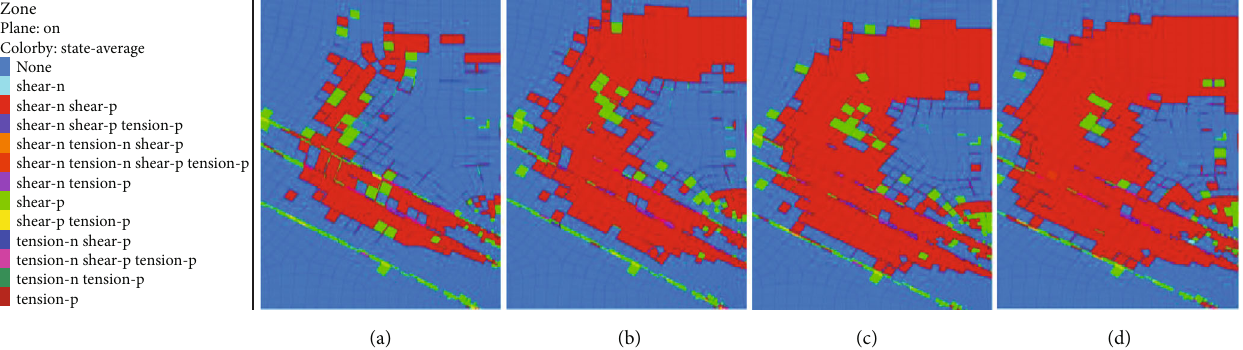
Figure 14: The plastic zone change of roadway roof in 302 mining area when the cutting position is 300m ahead of schedule. (a) Working face advancing 40m; (b) working face advancing 80 m; (c) working face advancing 120m; (d) working face advancing 160 m.